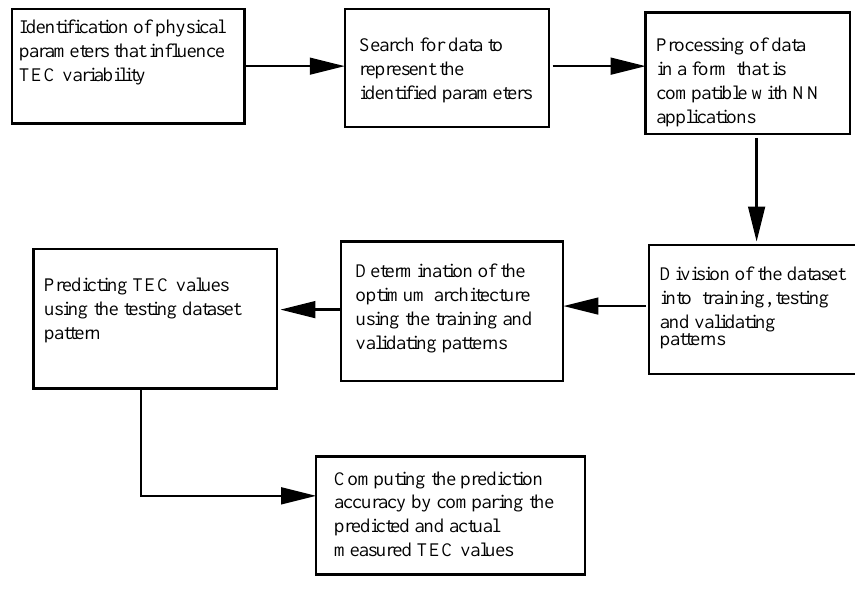
Fig. 2. A flow diagram illustrating the procedure followed during the modelling of TEC undertaken in this